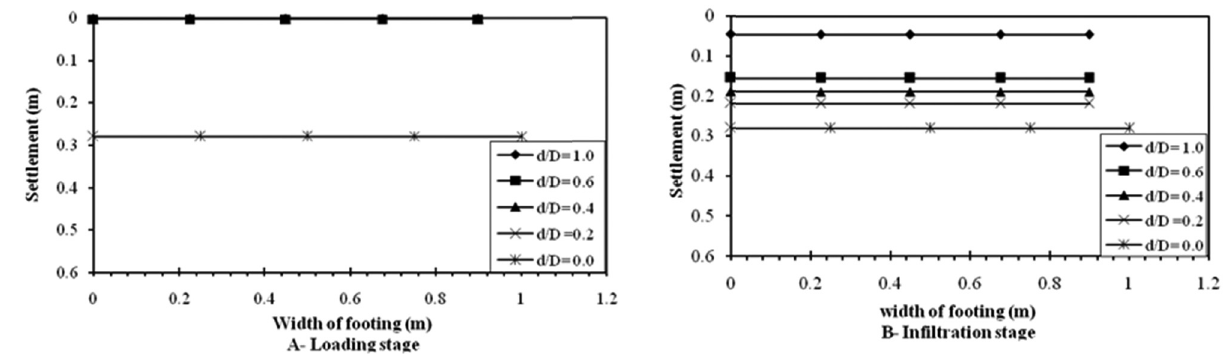
Figure 8: Settlement of soil with width of footing during di ff erent stages and skirt ratios.